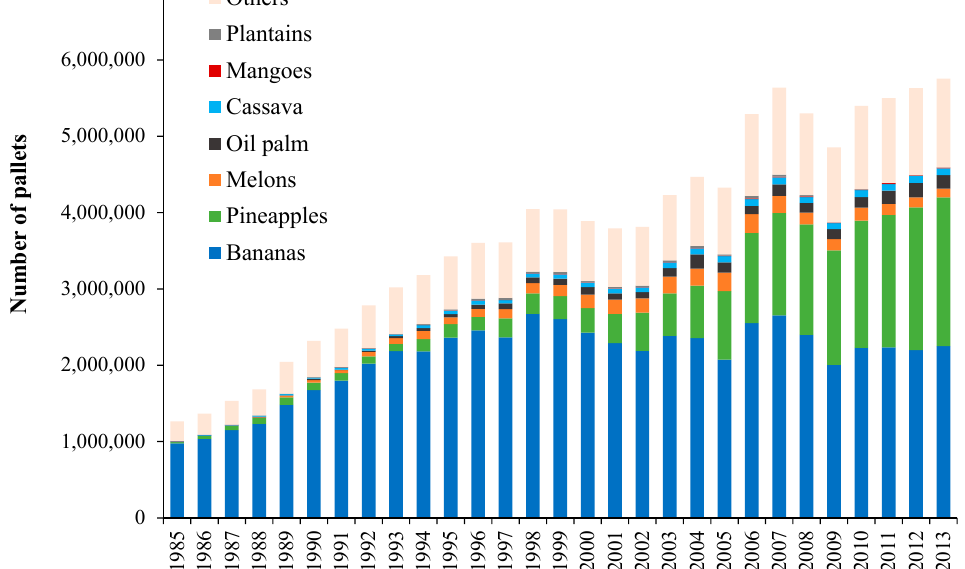
Figure 2. Estimates of annual demand for wood pallets by Costa Rica to export its agricultural and industrial products. The category “Others” includes industrial and other agricultural products.